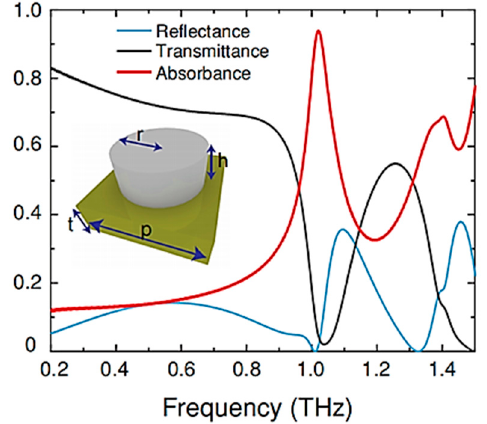
Figure 7. Simulated spectral reflectance (blue), transmittance (black), and absorbance (red) [46].